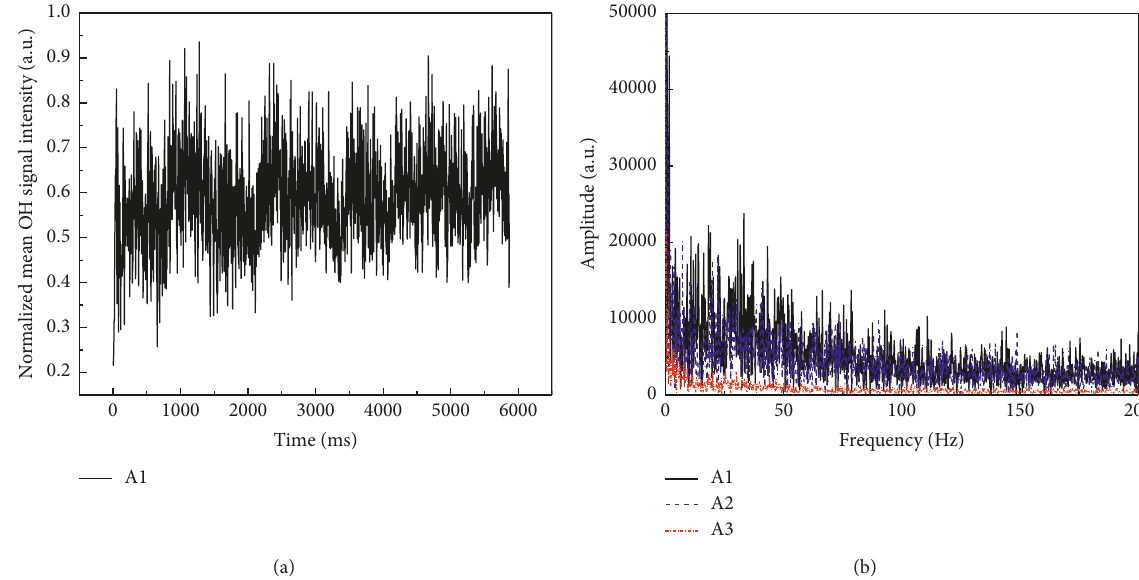
Figure 3: Oscillation curves of the normalized mean OH intensity. (a) Time-domain distribution of OH intensity. More than 2400 data are acquired, and the time interval is 2.5ms. (b) Frequency-domain distribution of OH